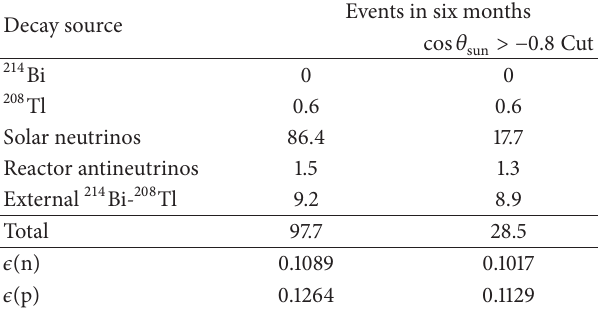
Table 6: Expected backgrounds in the 5.4–9 MeV energy region during six months of water fill. A fiducial volume cut of 5.5 m is applied to all events. The events after the cos 𝜃 also shown. 𝜖 (n) and 𝜖 (p) are the neutron and proton decay-mode detection efficiencies in the 5.5 mFV and energy window.